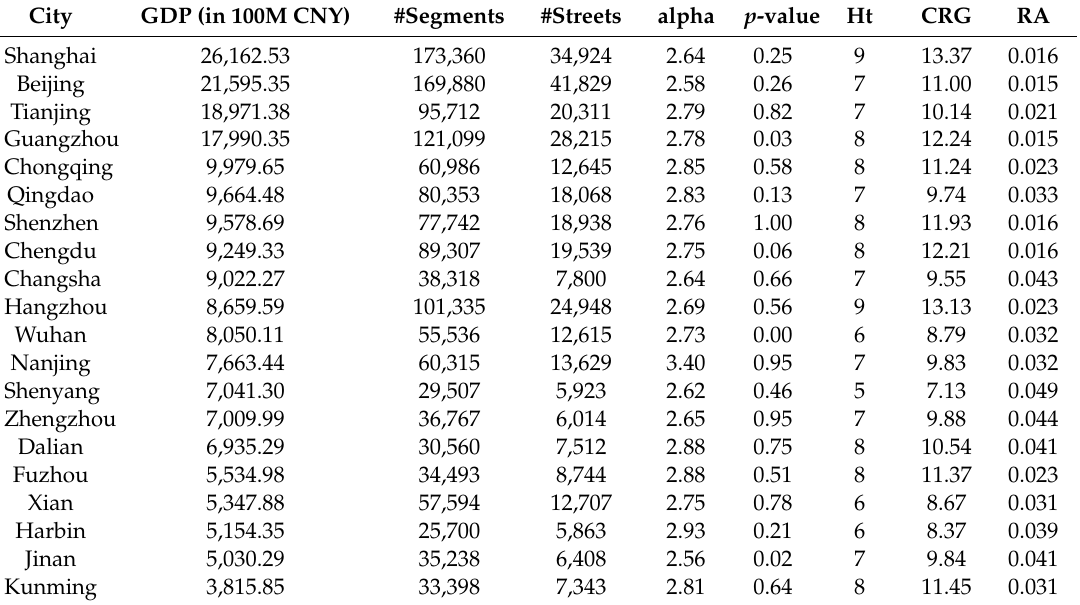
Table 4. Number of street segments, and resulting natural streets, and their fractal metrics among top 20 cities by Gross Domestic Product (GDP)